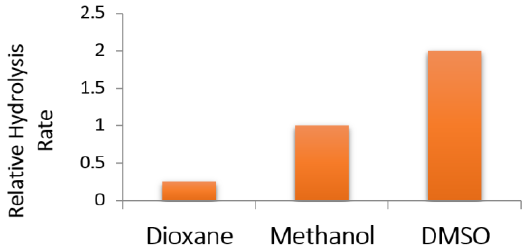
Figure 8. Effect of polarity of the solvent system on the rate of alkaline hydrolysis. Higher polarity of the solvent system accelerates the reaction. The rate of hydrolysis in methanol as a solvent was arbitrarily set at unity (1.0).